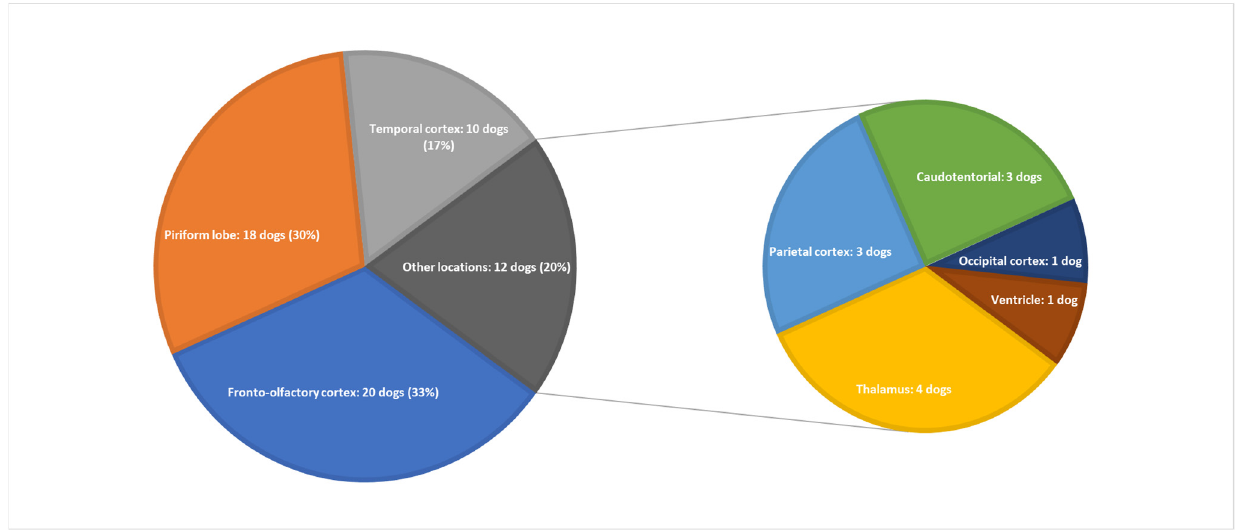
Figure 1. Suspected glioma location in the 60 dogs studied.